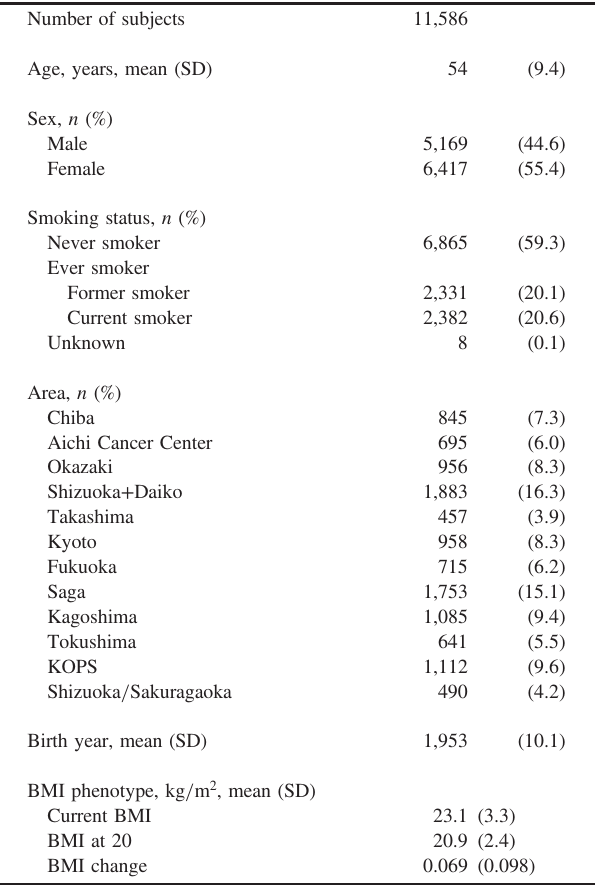
Table 1. Baseline characteristics of study subjects Number of